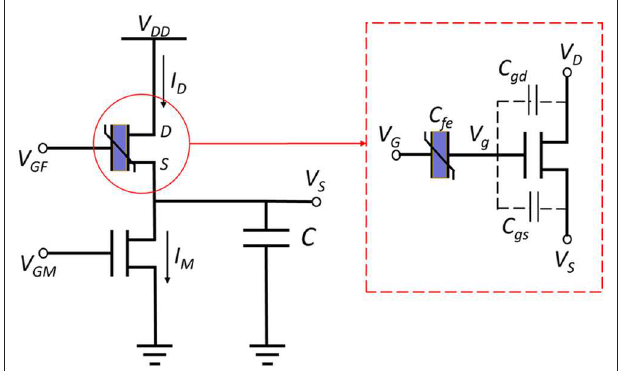
FIGURE 1 | FeFET based spiking oscillator consists of a FeFET and a normal NMOS transistor that are used to charge and discharge a capacitor. The FeFET (red box) can be view as a ferroelectric layer that connected to a common FET (3D model of FeFET is shown in Figure S1 ).